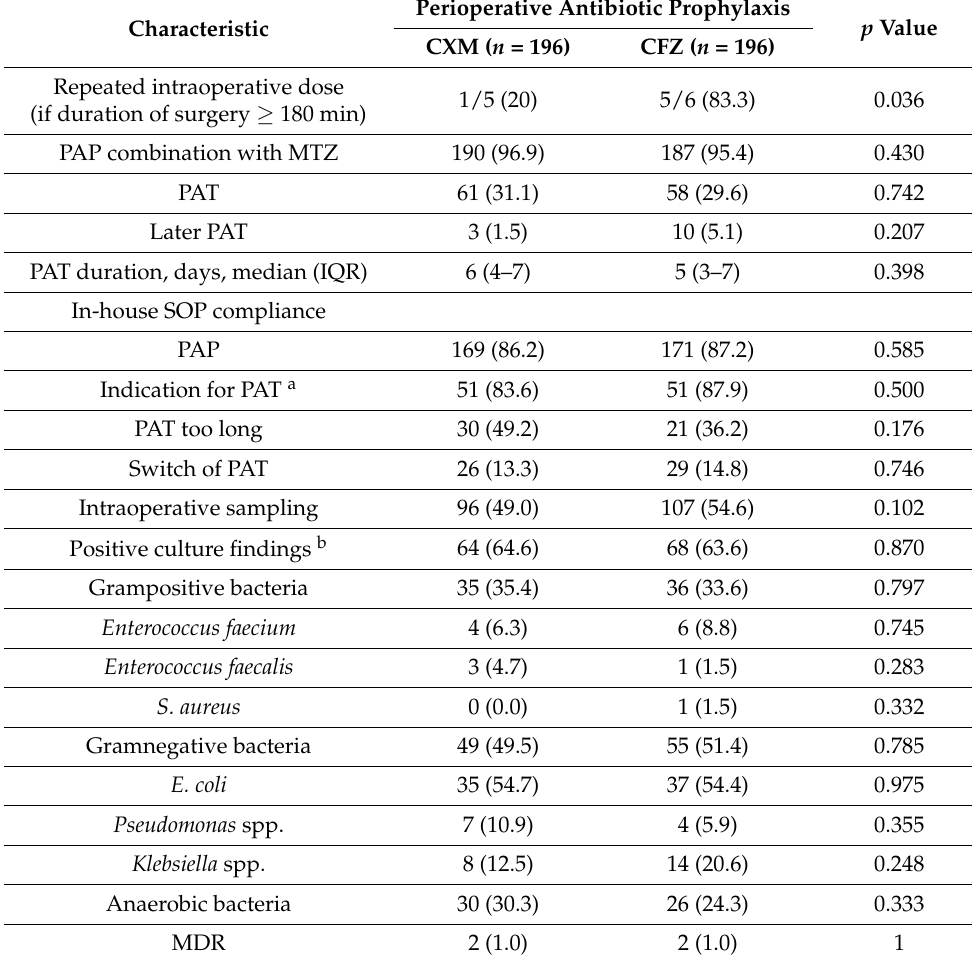
Table 4. Antibiotic therapy and